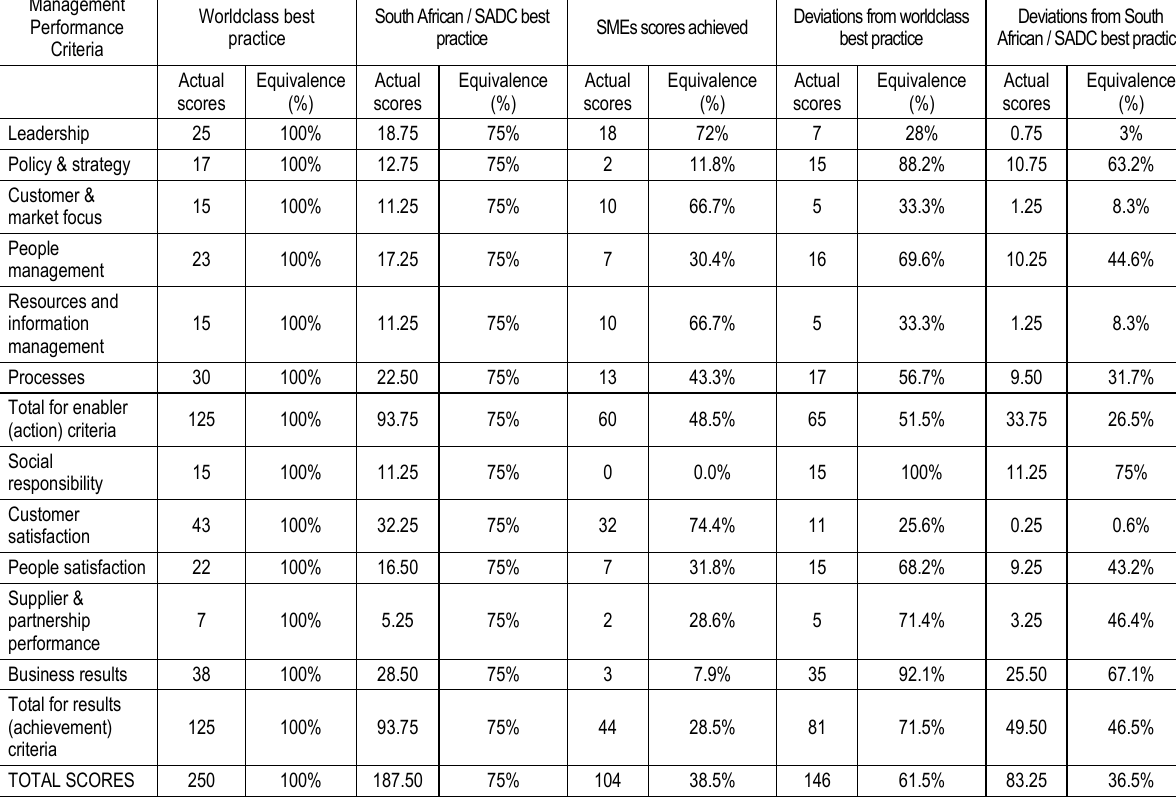
Table 5. SMEs ’ management performance criteria scores